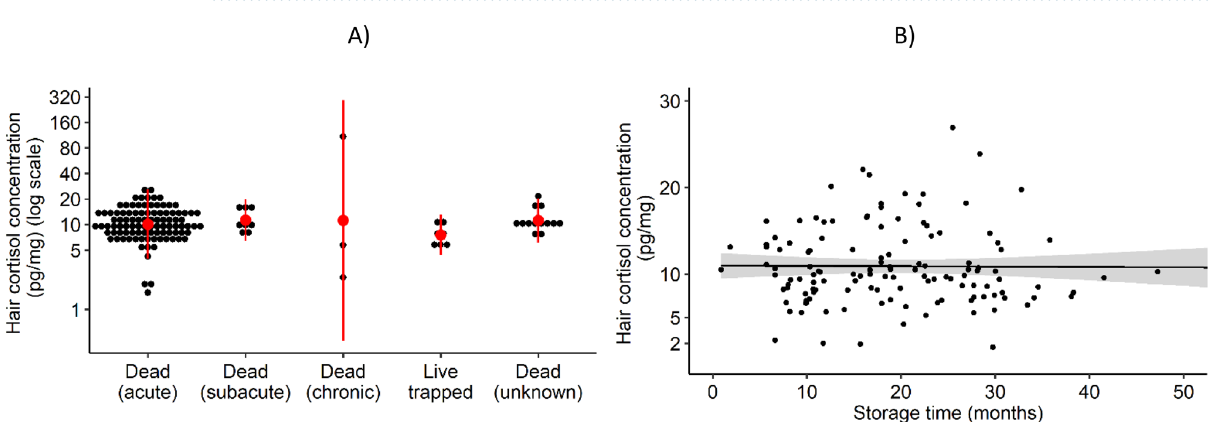
Figure 4. Hair cortisol concentration by selected methodological determinants. ( A ) Cause of death/capture: mean ± 2 standard deviations (in red) of hair cortisol concentration measured in lumbar guard hair samples. ( B ) Sample storage: linear regression between measured hair cortisol concentration and time from death/capture to cortisol extraction with the 95% confidence interval as shaded grey